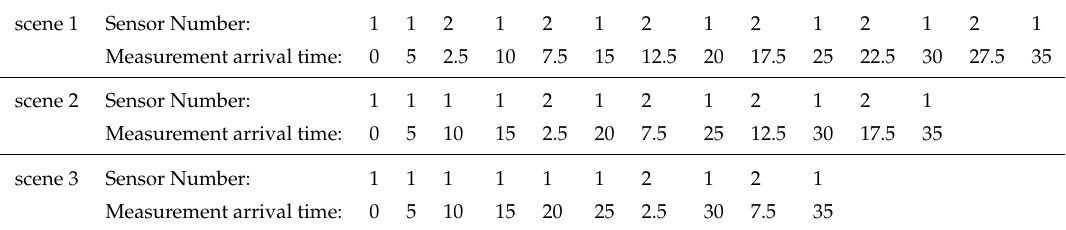
Table 1. Typical Out-of-Sequence Measurement (OOSM) scenario for one, three, and five lags. scene